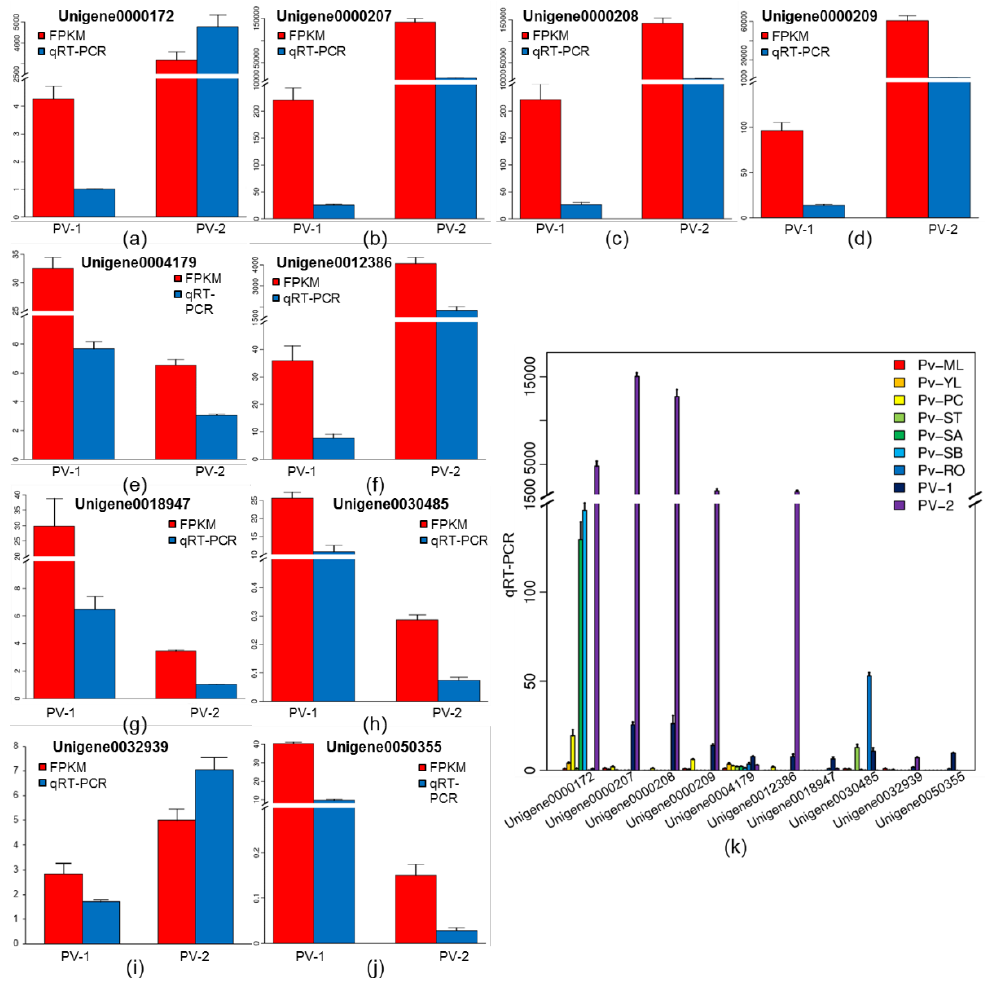
Figure 5. ( a – j ) Verification of the consistency of the RNA-Seq data using quantitative real-time PCR (qRT-PCR). ( k ) The expression patterns of the description of ten RIP genes in nine organs of P. volubilis . Pv-ML, mature leaf; Pv-YL, young leaf; Pv-PC, pericarp; Pv-ST, stem; Pv-SA, stem apex; Pv-SB, stem bark; Pv-RO, root young leaves. Error bars ± SD from 3 biologicals. The data were subjected to Student’s t -test.